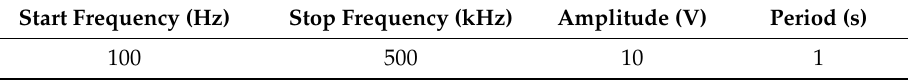
Figure 4. Moisture exposure. ( a ) Immersed in water; ( b ) contained in Ziploc sealed plastic bag. Table 1. Experimental details of the swept sine wave signal.